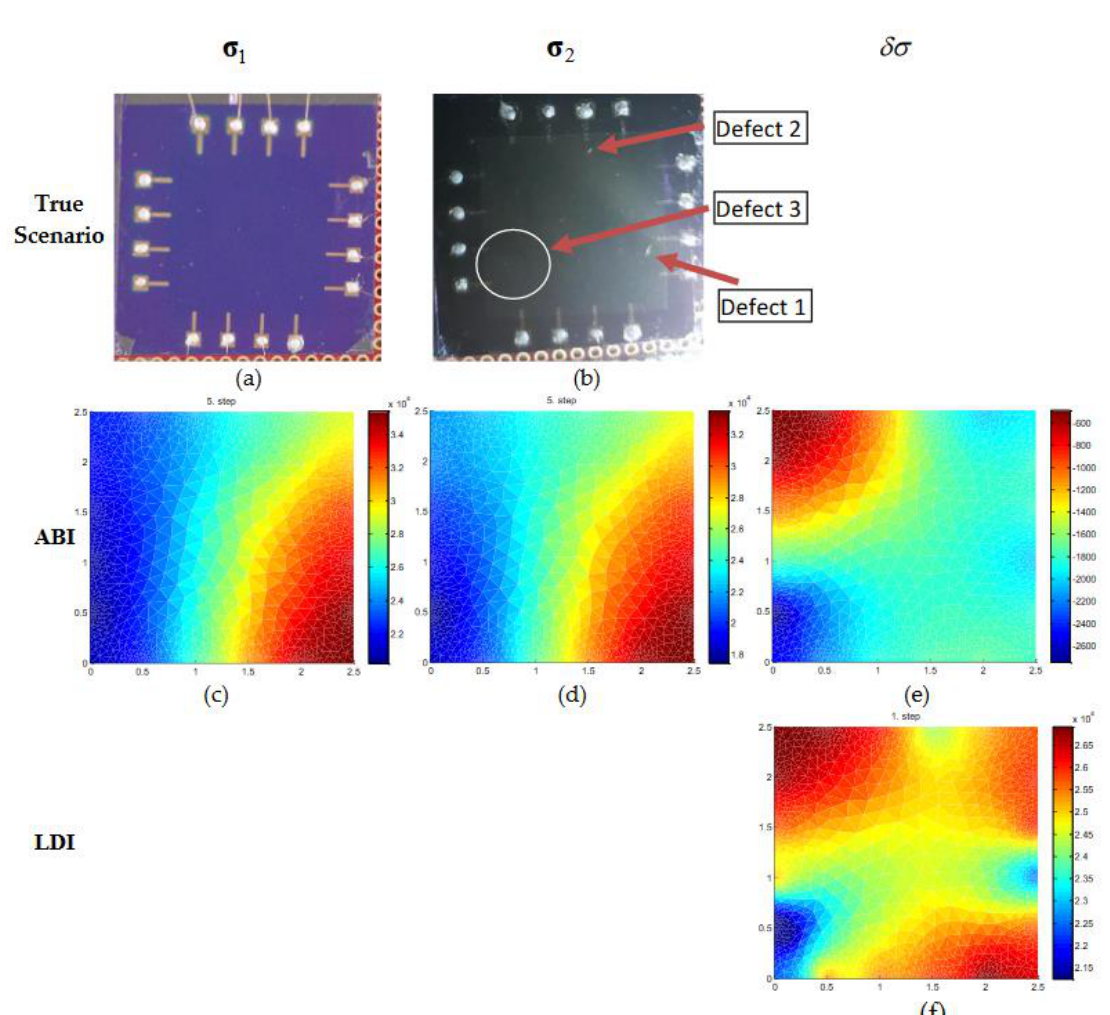
× 2.5 cm. ( a , b ) the top row